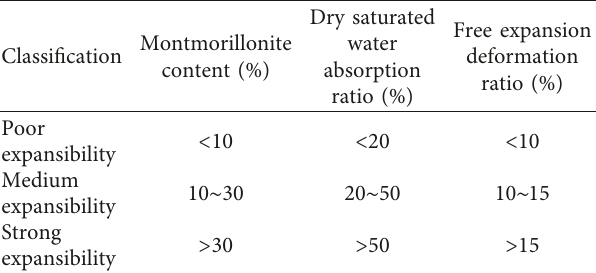
Table 2: Classification criterion of swelling soft rock by He Manchao.